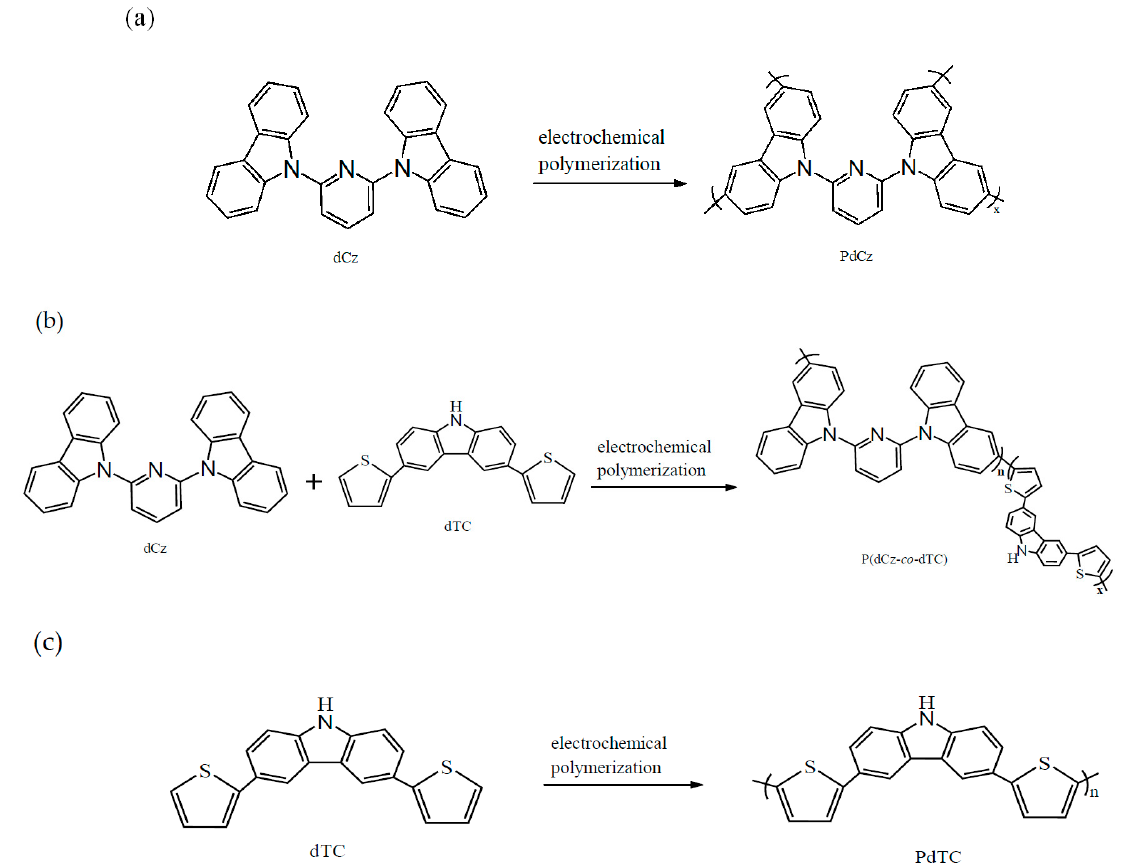
Figure 3. The electrochemical polymerization routes of ( a ) PdCz; ( b ) P(dCz- co -dTC) and ( c ) PdTC.